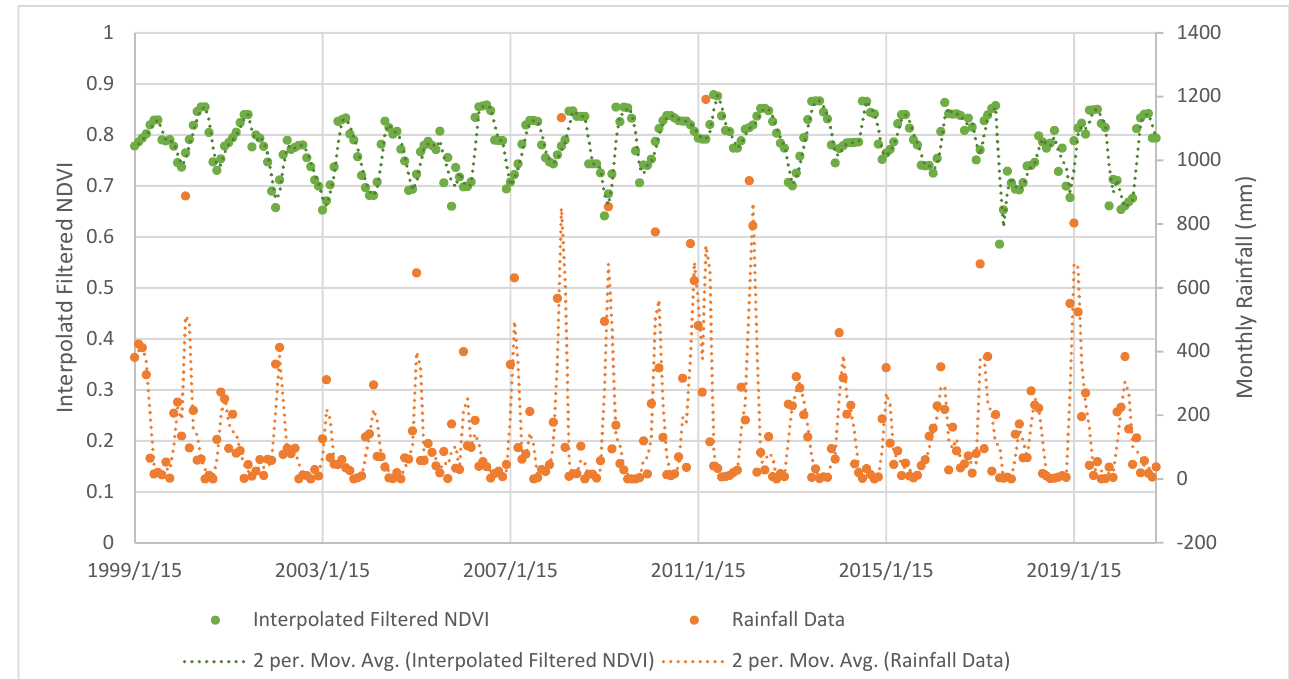
Figure 9. Interpolated, filtered NDVI and rainfall trendlines for the northern section of our study region, Repulse Bay, rainfall data gathered from Lethebrook Station (station number: 33041).